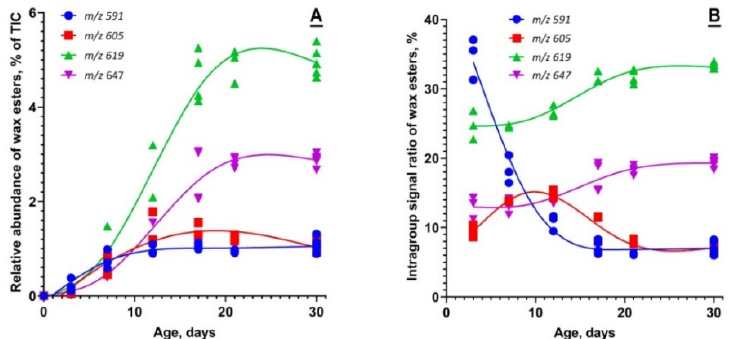
Figure 7. The wax ester (WE) profile of developing and maturing Meibomian glands undergoes age-related changes. ( A ) The relative abundances of four typical WEs with m / z values of 591.6076, 605.6240, 619.6401, and 647.6693 illustrate the tendency of the overall WE pool to increase from P0 to P30. ( B ) However, the relative abundances of shorter-chain WEs tend to decline, while the relative abundances of extremely long-chain WEs tend to increase.